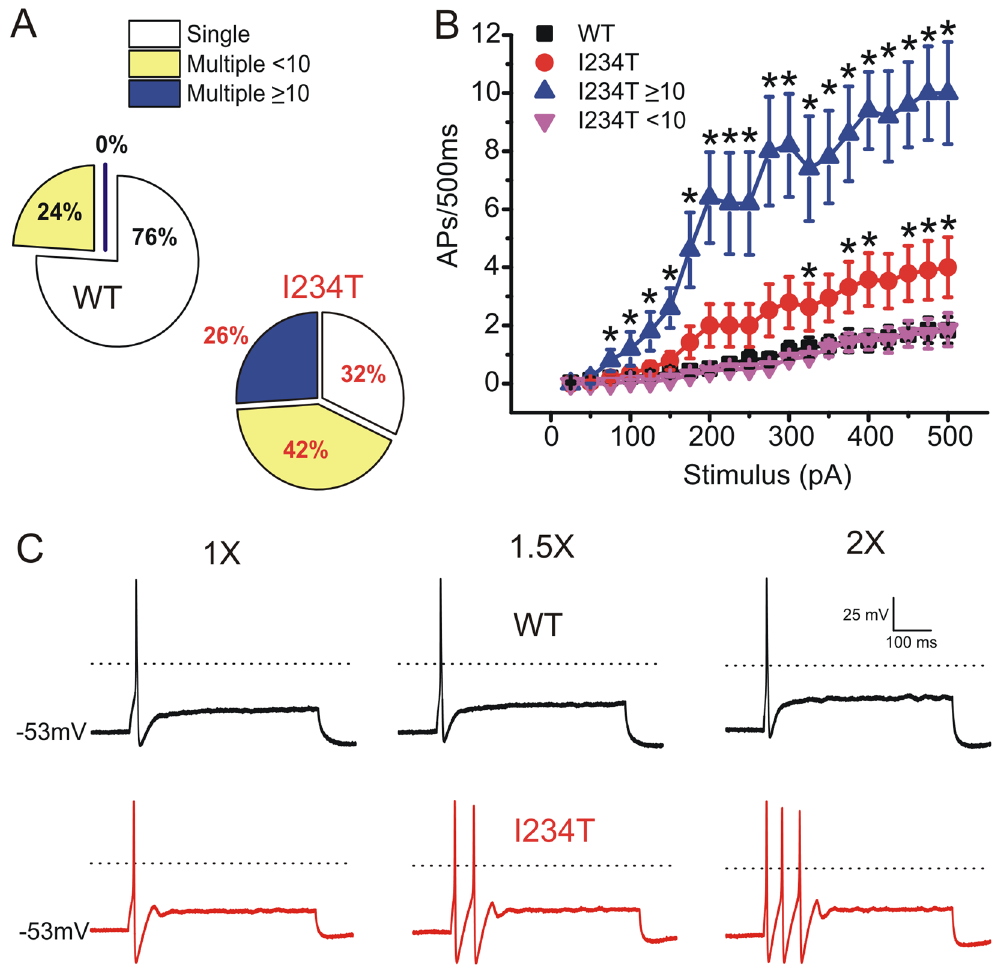
Figure 3. Expression of I234T produces hyperexcitability in DRG neurons that are excitable at native resting potential. ( A ) Populations of cells expressing either WT or I234T maximally fired single action potential (white), < 10 (yellow) and ≥ 10 action potentials (blue) in response to graded 500 ms current stimuli of 25 to 500 pA in 25 pA increments. ( B ) Average firing frequencies in cells expressing WT (black) or I234T (red) in response to 500 ms graded inputs from 25 to 500 pA in 25 pA increments. Cells expressing I234T were divided into high- and low-firing groups, which elicited maximally ≥ 10 (blue) and < 10 (magenta) action potentials over 500 ms, respectively. ( C ) Responses of a DRG neuron expressing WT (upper) or I234T (lower) to 500 ms depolarizing current steps that are 1-, 1.5- and 2-fold current threshold,